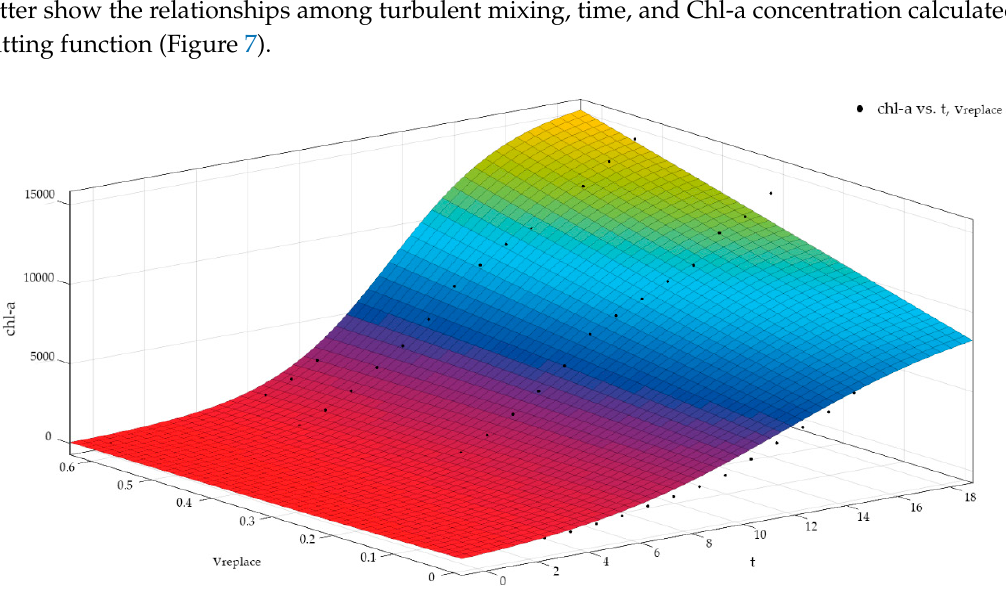
Table 2. The fitting evaluation parameters for the maximum Chl-a concentration.